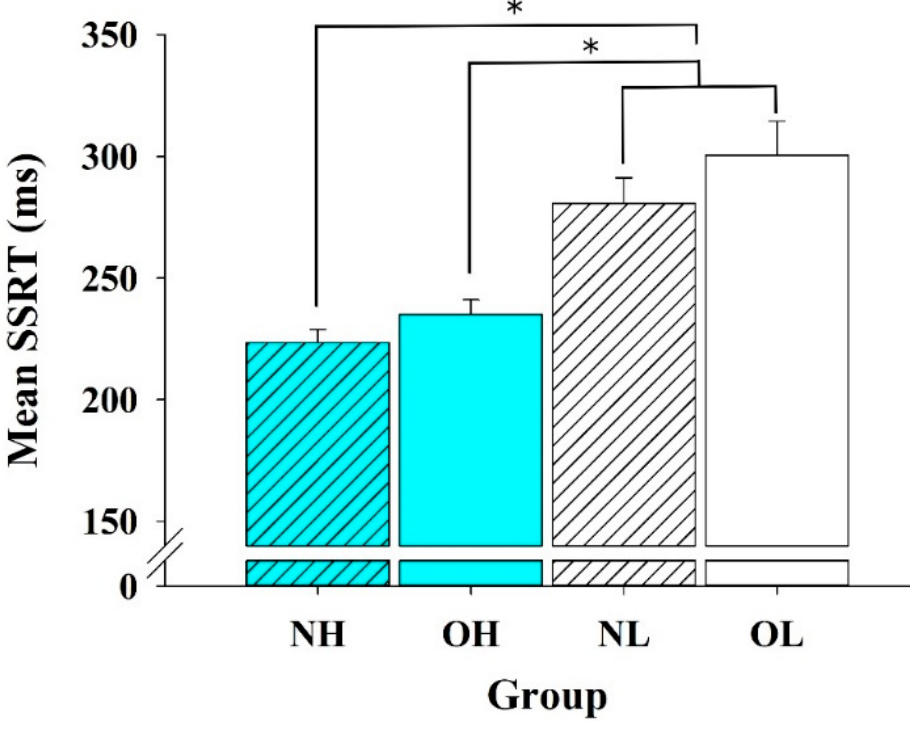
Figure 2. Comparisons of the stop-signal response time (SSRT) across the four groups (means ± SE). NH = High CRF with normal weight; OH = high CRF with obesity; NL = low CRF with normal weight; and OL = low CRF with obesity. * p < 0.05.